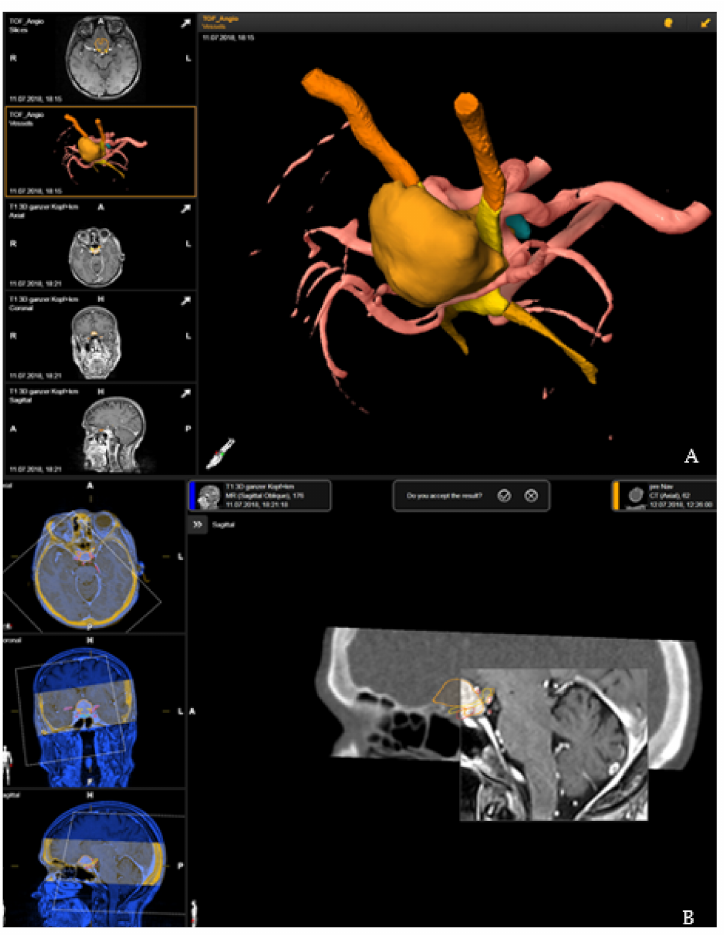
Figure 1. Preoperative planning and image fusion for 67-year-old female patient with suprasellar meningioma (patient no. 19). ( A ) Visualization of the tumor (ochre), optic nerves and tract (orange) and optic chiasms (yellow) as a 3D object following segmentation in T1-weighted post-contrast magnetic resonance imaging (MRI) and time-of-flight (TOF) MRI angiography. ( B ) Rigid fusion of computed tomography scan with T1-weighted MRI